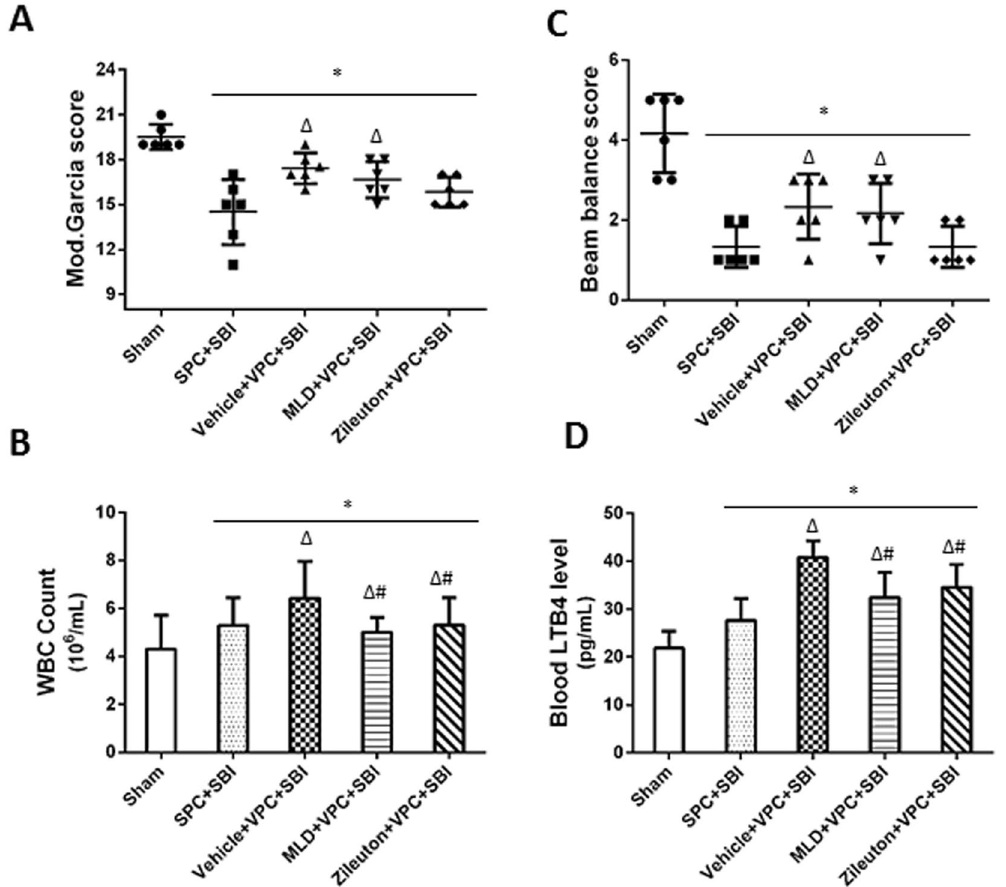
Figure 6. Effects of Manoalide and Zileuton administration with venom preconditioning (VPC) on neurological scores, peripheral WBC count and blood LTB4 level 24 h after SBI. VPC improved modified Garcia neurological score (A) and beam balance score (C) compared to SPC + SBI group. Manoalide and Zileuton did not reverse the beneficial effect of VPC on neurological scores. The peripheral WBC count (B) and blood LTB4 level (D) was increased in VPC + SBI group compared to SPC + SBI, which was reversed with Manoalide and Zileuton. * p < 0.05 vs Sham, ∆ p < 0.05 vs SPC + SBI, # p < 0.05 vs VPC + SBI. Data are shown as mean ± SD. n =